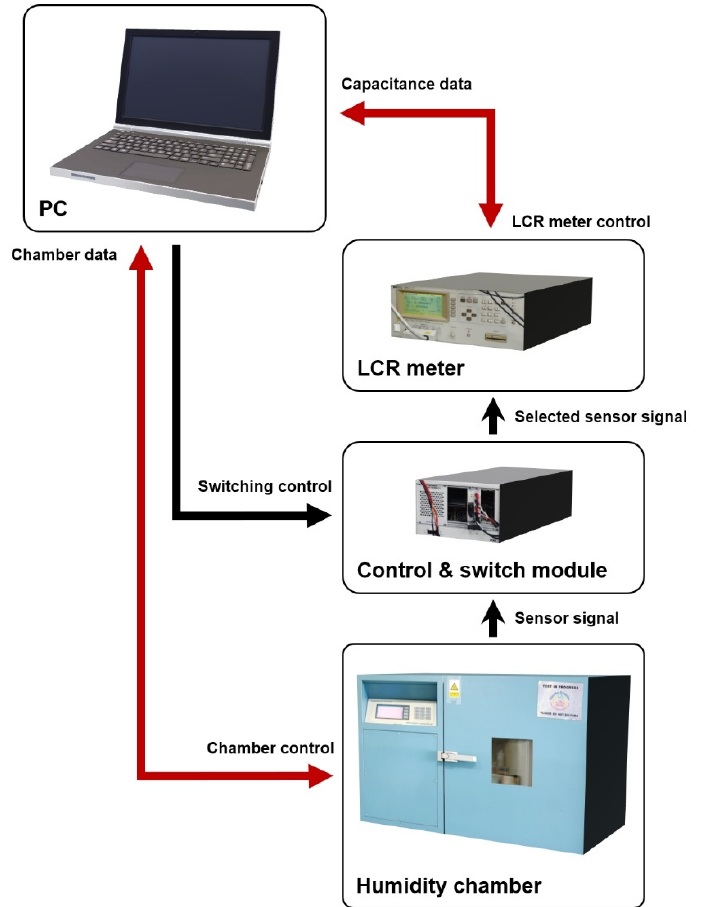
Figure 2. Schematic diagram of the measurement